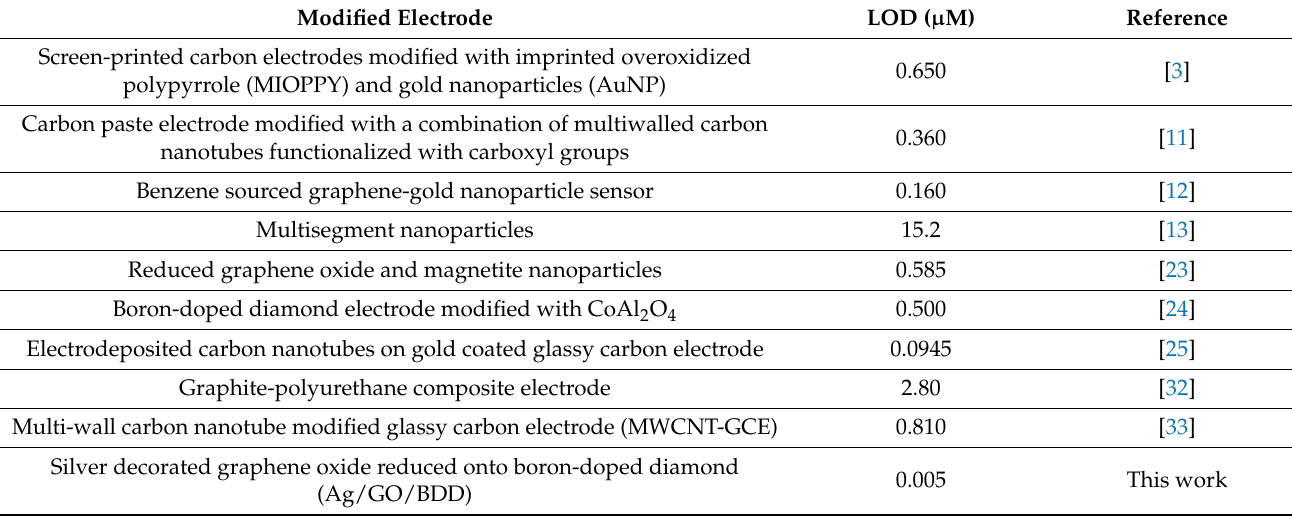
Table 6. Comparison of the lowest limit of detection (LOD) obtained in this study with other reported works. Modified Electrode LOD ( µ M)